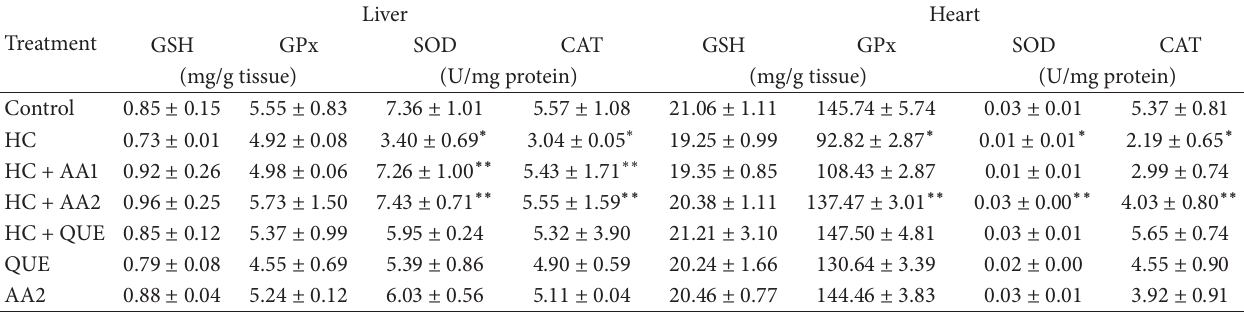
Table 4: Changes in the levels of hepatic and cardiac antioxidant parameters in hypercholesterolemic rats treated with methanol extract of Artocarpus altilis for nine